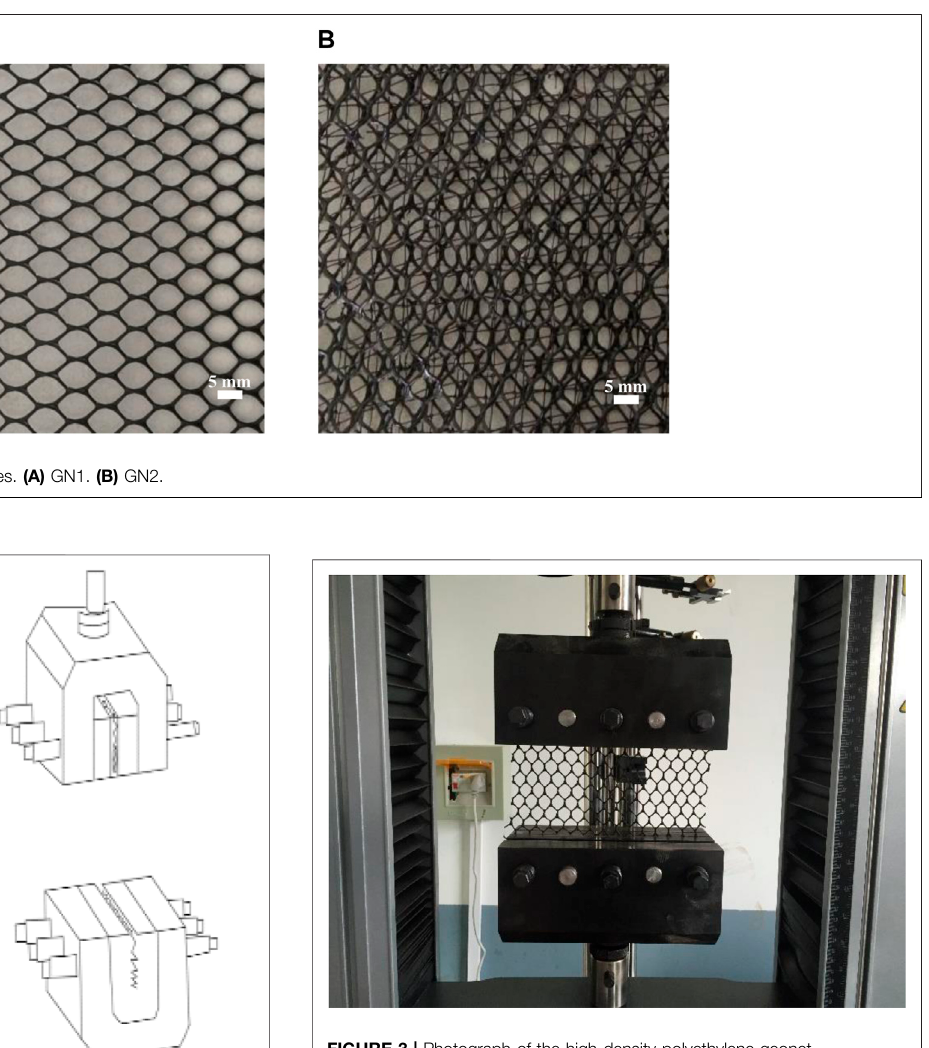
FIGURE 3 | Photograph of the high-density polyethylene